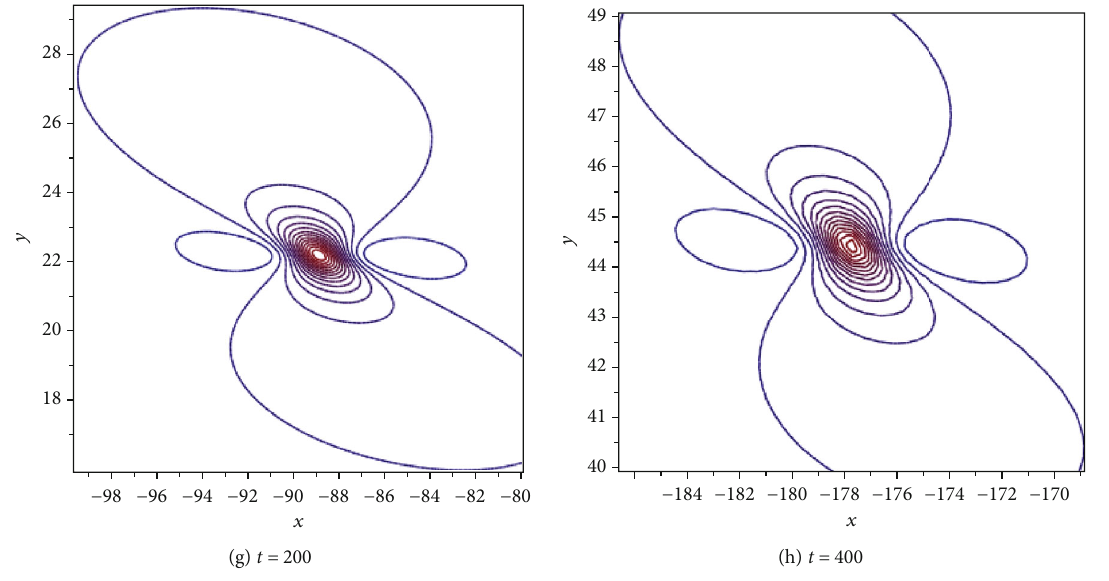
Figure 3: (Color online) The lump solutions v to Equation (6) at α = 3